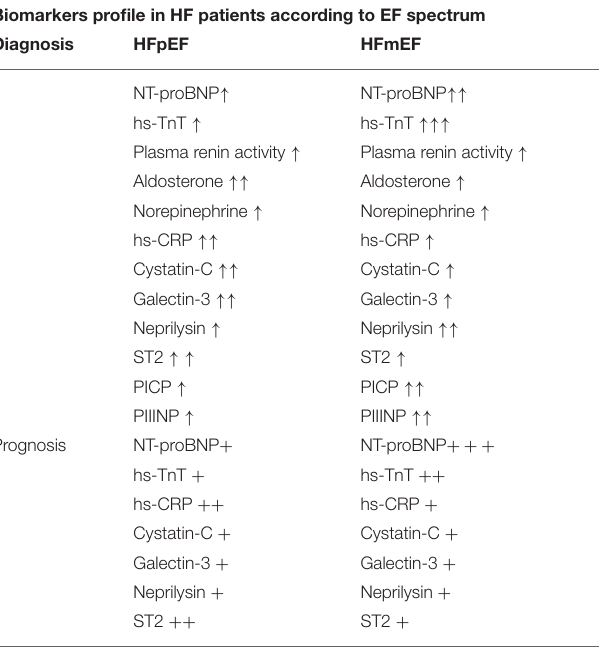
TABLE 2 | Biomarker characteristics and differences existing between HFmrEF and HFpEF. Biomarkers profile in HF patients according to EF